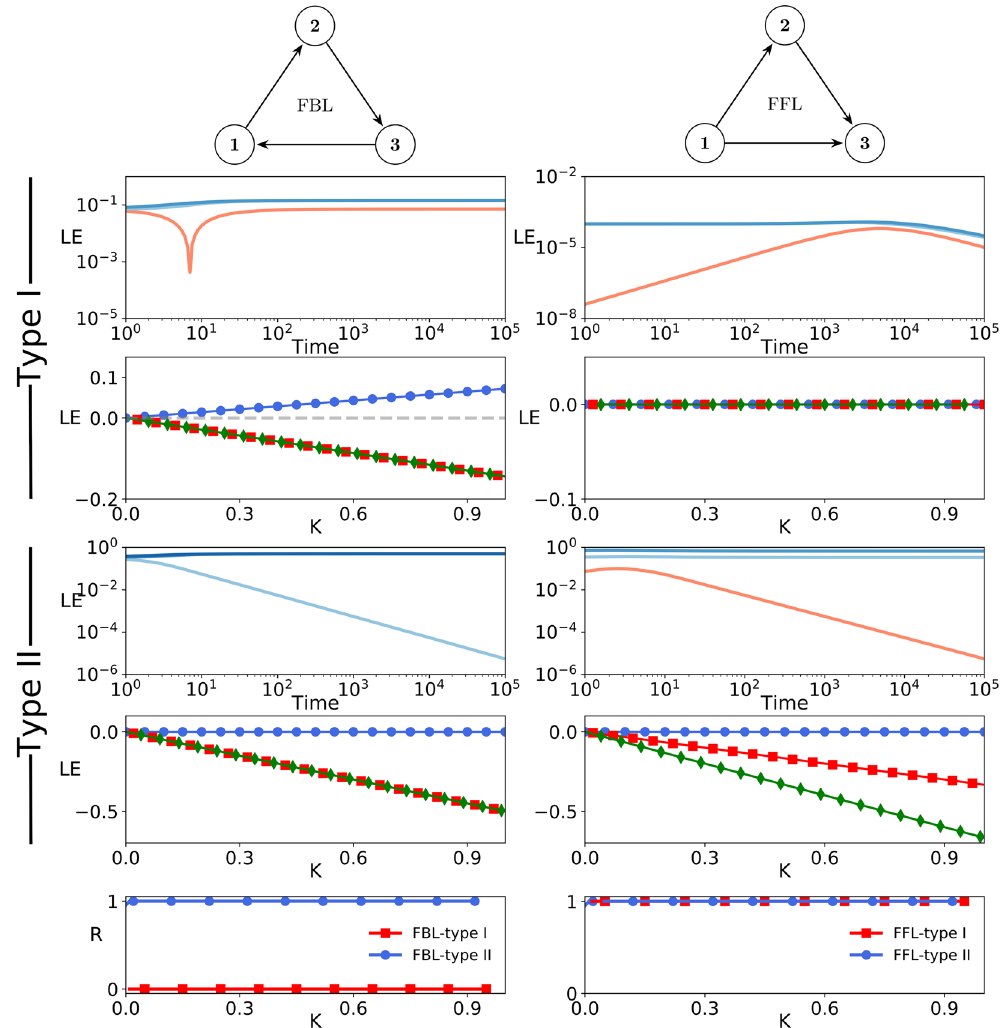
Figure 2. Synchronization stability of excitatory FBL and FFL motifs. (Top four rows) the Lyapunov exponents versus time (log-log scale) and the coupling for identical type I and type II excitatory phase oscillators connected by FBL (left column) and FFL loops (right column). The sign of Lyapunov exponents in the log-log plots are colour coded, where blue and red indicate negative and positive values, respectively. (Bottom row) The stationary order parameter versus coupling for identical type I and type II phase oscillators connected by FBL (left column) and FFL loops (right